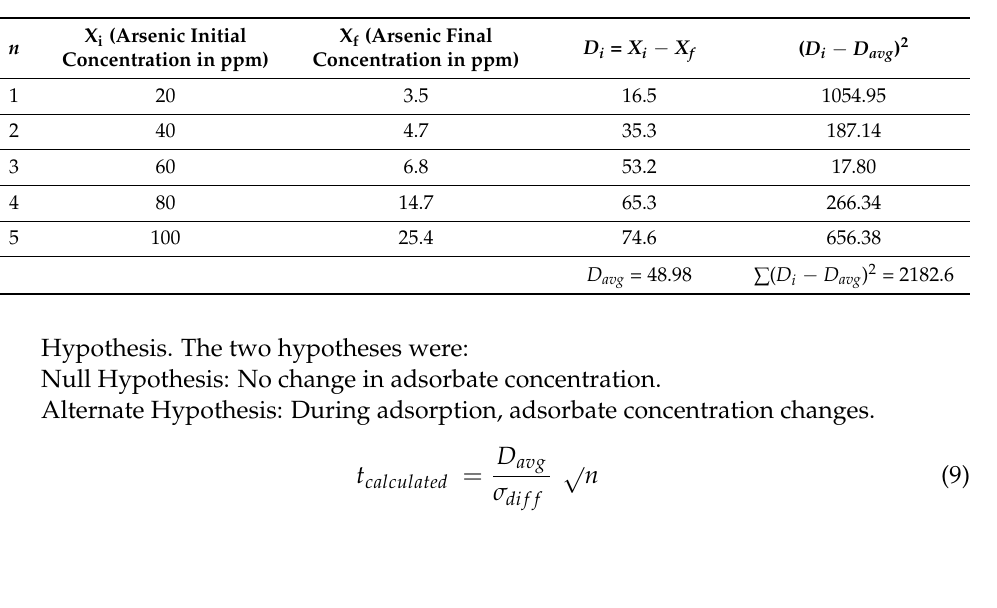
Table 3. Change in concentration of arsenic(III) during